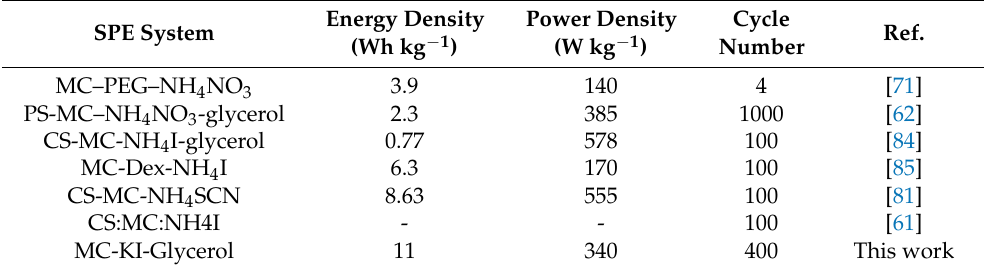
Table 5. Polymer-based electrolyte EDLC device performance. Energy Density SPE System (Wh kg − 1